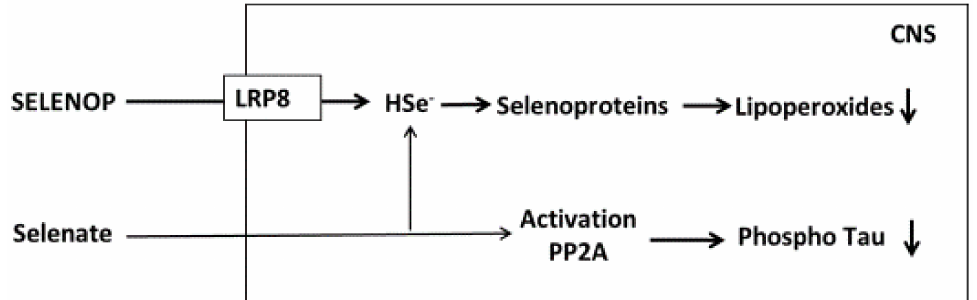
Figure 4. Uptake of selenoprotein P (SELENOP) and selenate in CNS. Selenoprotein P is imported into CNS via the ApoE-receptor LRP8 and is crucial for the synthesis of antioxidative selenoenzymes. Selenate is presumed to be imported by an anion carrier and is hypothesized to act as an activator of protein phosphatase 2 (PP2A), thereby reducing tau phosphorylation (see text). Selenate may also support selenoprotein